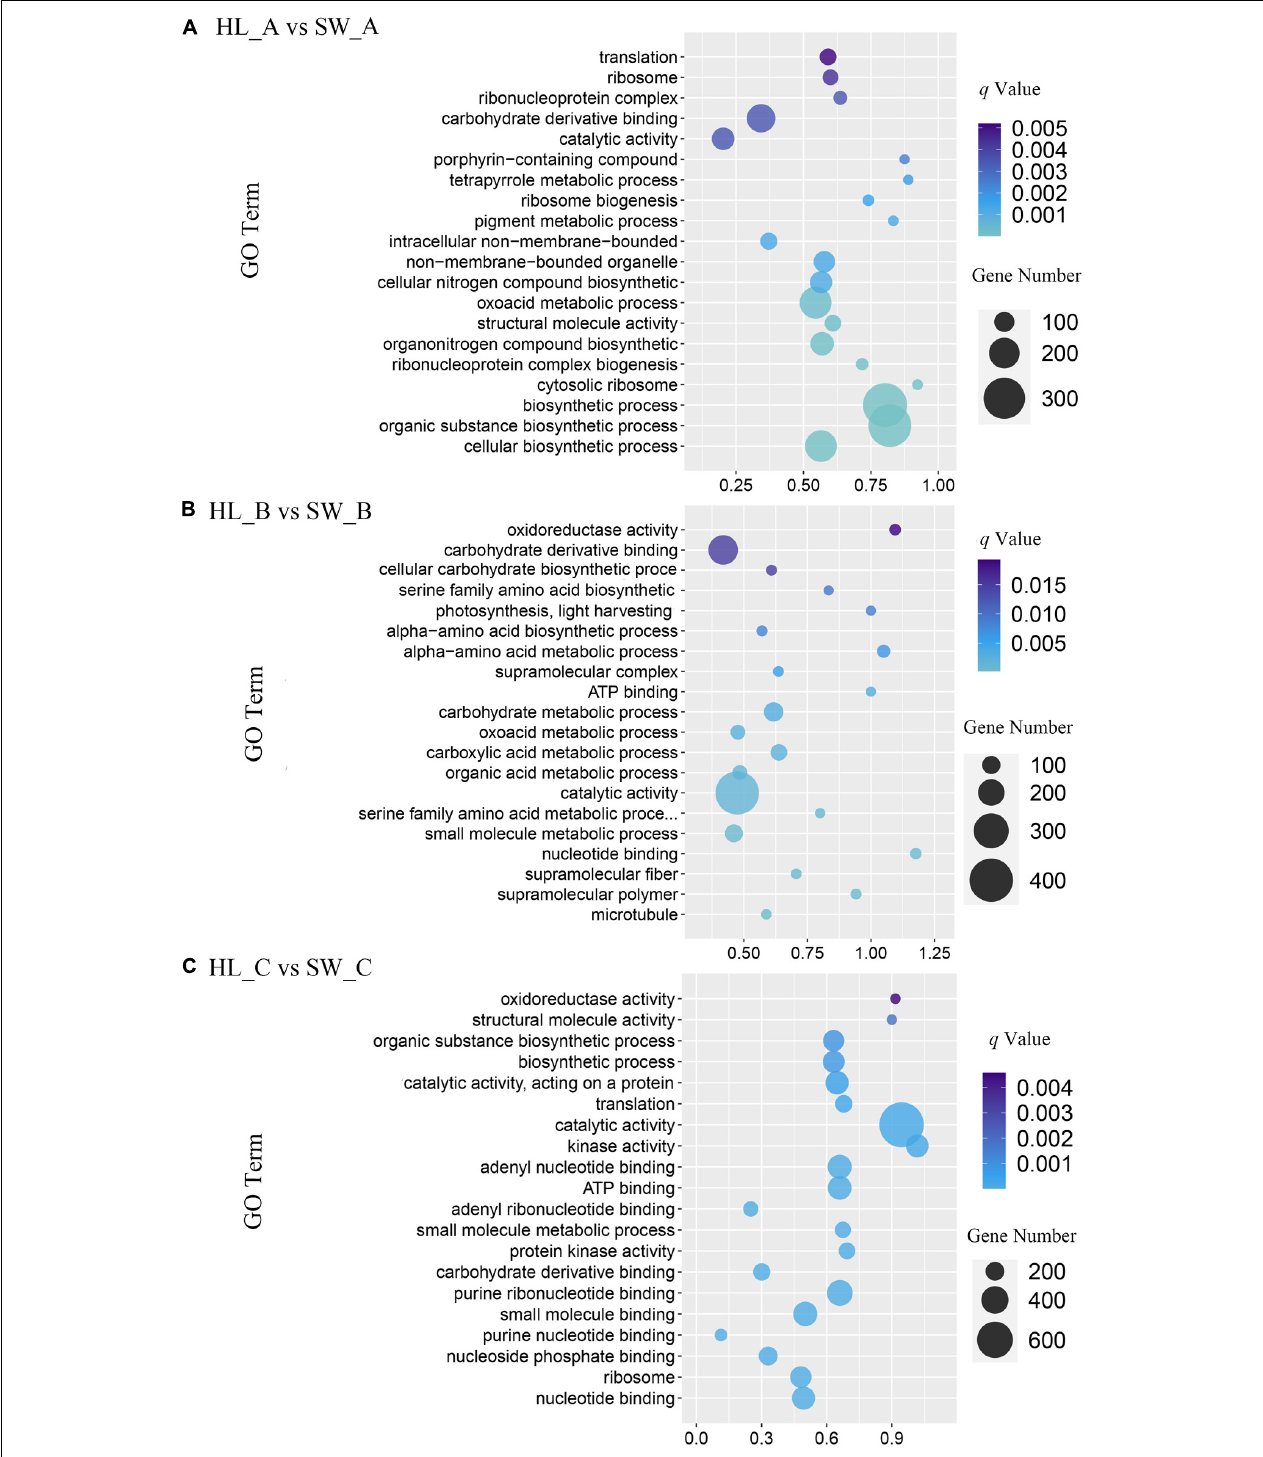
FIGURE 5 | Gene ontology (GO) pathway analysis of differentially expressed genes. Advanced bubble chart shows enrichment of differentially expressed genes in certain pathways. (A) HL_A vs. SW_A; (B) HL_B vs. SW_B; and (C) HL_C vs. SW_C. Count represents the DEGs number, and gene ratios are calculated as the ratio of DEGs in each GO pathway compared with total number of